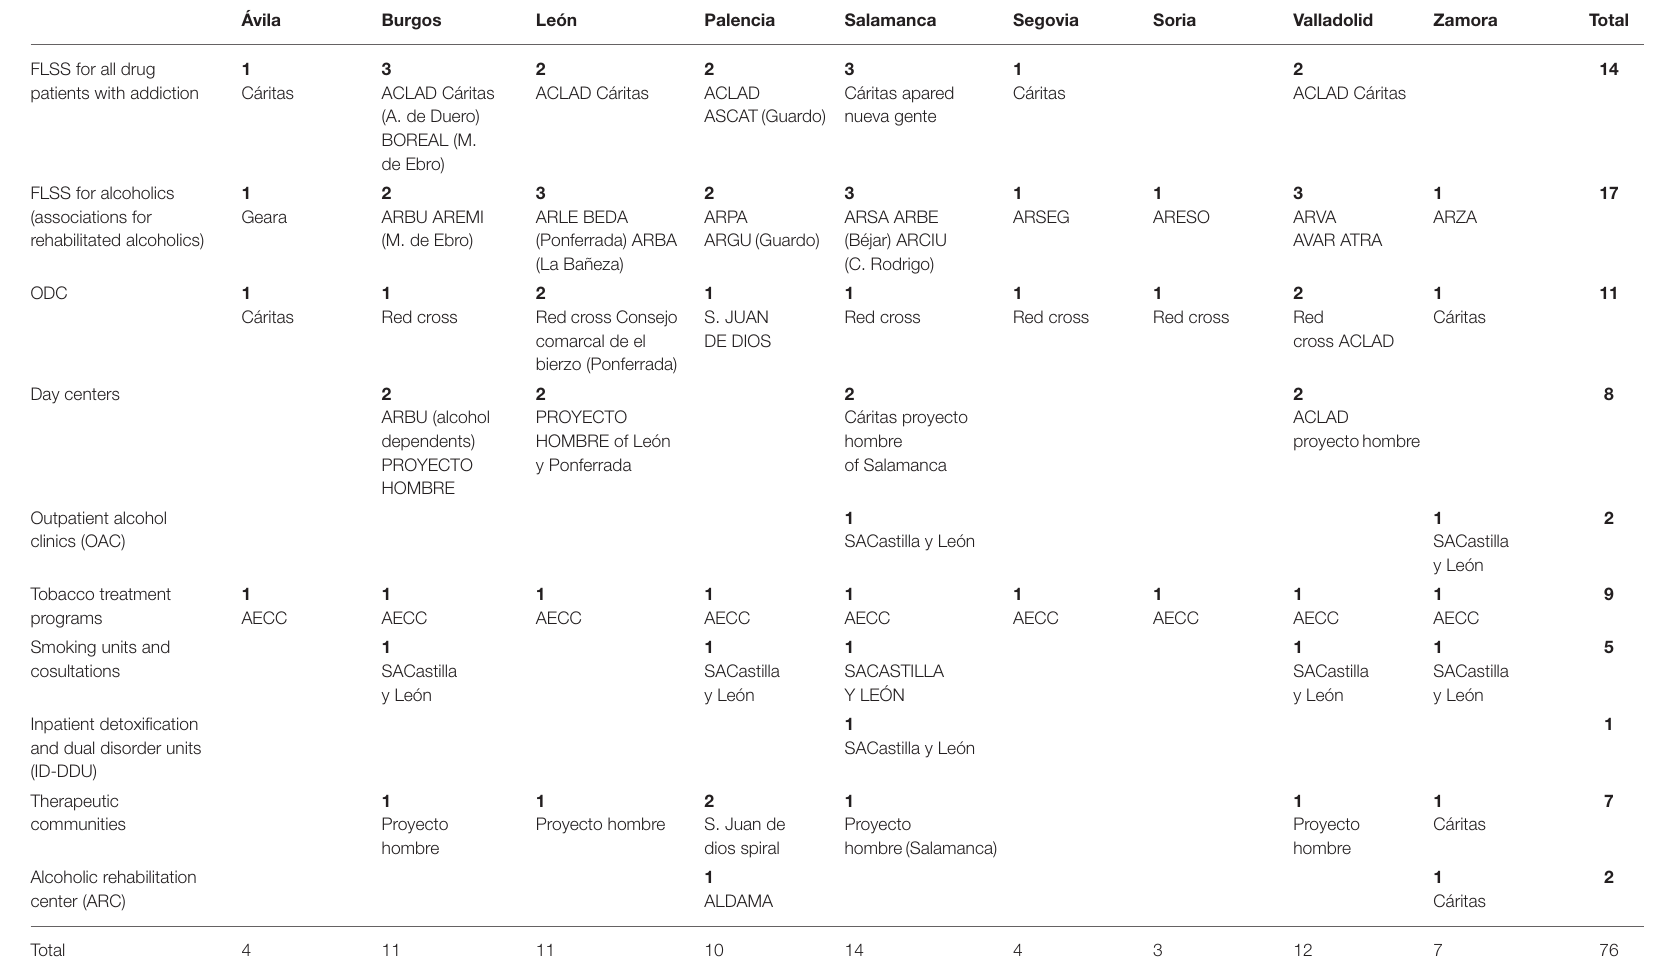
TABLE 2 | Resources of the network for addiction treatment in castile and Leon (DDACYL)